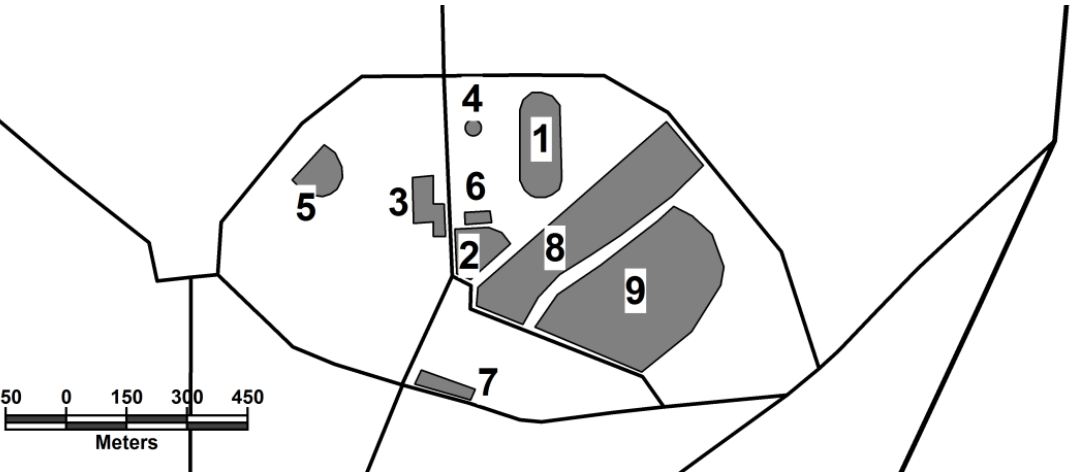
Figure 5. The most important buildings in Great Forest in the second half of the 1980s Source: own work. (1—stadium, 2—boating pond, 3—bath, 4—water tower, 5—outdoor theatre, 6—new restau- rants (Új Vígadó), 7- new hotel, 8—amusement park and zoo, 9—sports park)